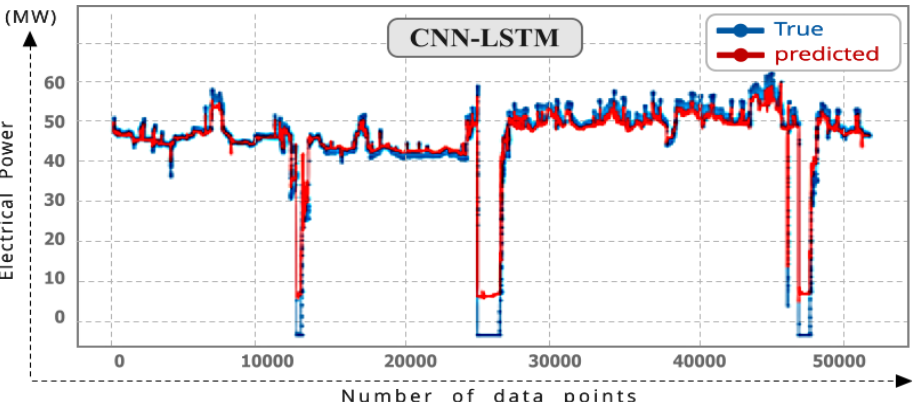
Figure 9. Hybrid CNN-LSTM prediction results versus actual results.